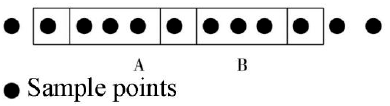
Figure 3. Principle of the moving split window technique.